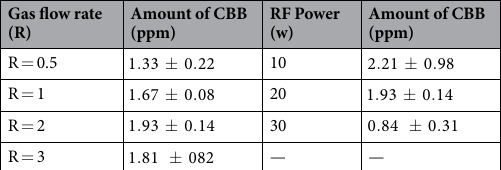
Table 2. The amount of CBB absorbed by the L-PPA:N in functions of gas flow rate (R = N 2 /C 2 H 2 ) at constant 20 W power and RF power at constant R = 2, respectively.